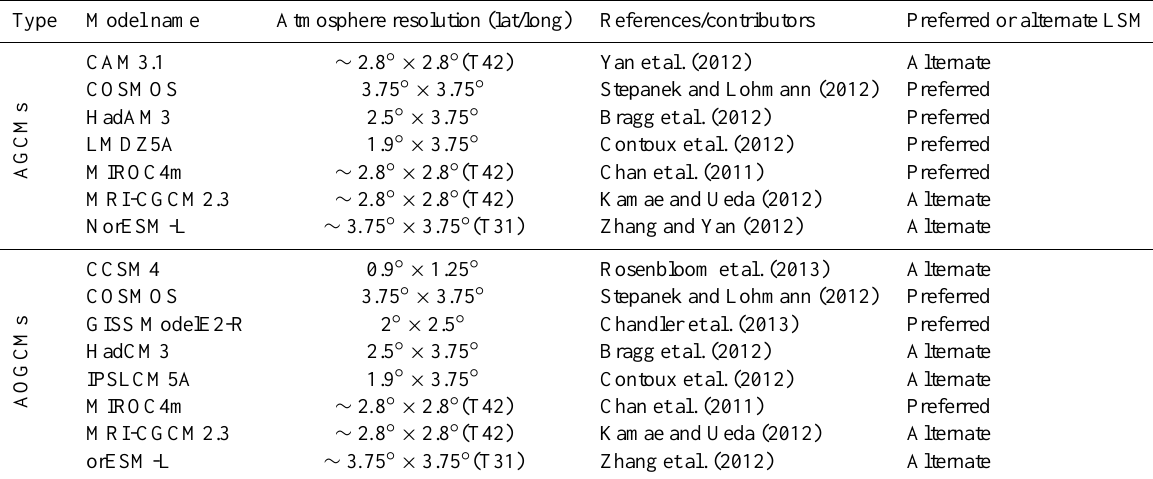
Table 1. The short names of the PlioMIP climate models used to force BASISM, along with the atmospheric component resolution and the land–sea mask (LSM) scheme implemented by each model (Haywood et al., 2010). Regarding the LSM, “preferred” refers to a LSM that has been entirely altered to meet the PlioMIP boundary conditions, whereas “alternate” is where modelling groups have had to use more similar to modern LSM. More comprehensive details of each model, and their implementation of the LSM, can be found in Haywood et al. (2013) and the individual references listed in this